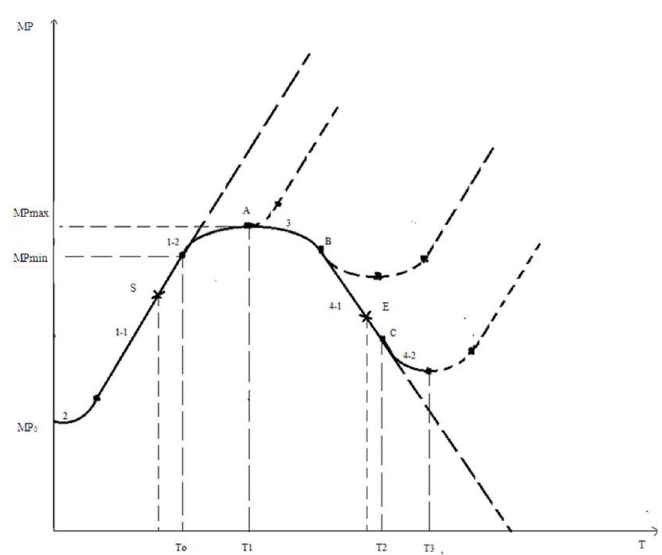
Figure 2. Life cycle graph of the technological development of production systems [45], where T is the time period. MP—material productivity; 2, 1-1, 1-2, 3, 4-1, and 4-2—life cycle stages; A—point corresponding to the maximum possible value of MP; A, B, and C—points showing the possibilities of the transition to a new technological development cycle; S—point showing the beginning of a favorable transition to a new development technology; E—point showing the necessary start of the transition to a new development technology to avoid enterprise bankruptcy; М Po—the initial level of material productivity at the enterprise during the transition to a new development technology; М Pmin—the level of material productivity after which the value of the coefficient of the manufacturability level of production begins to decrease; М Pmax—the maximum possible level of material productivity with the existing production technology.